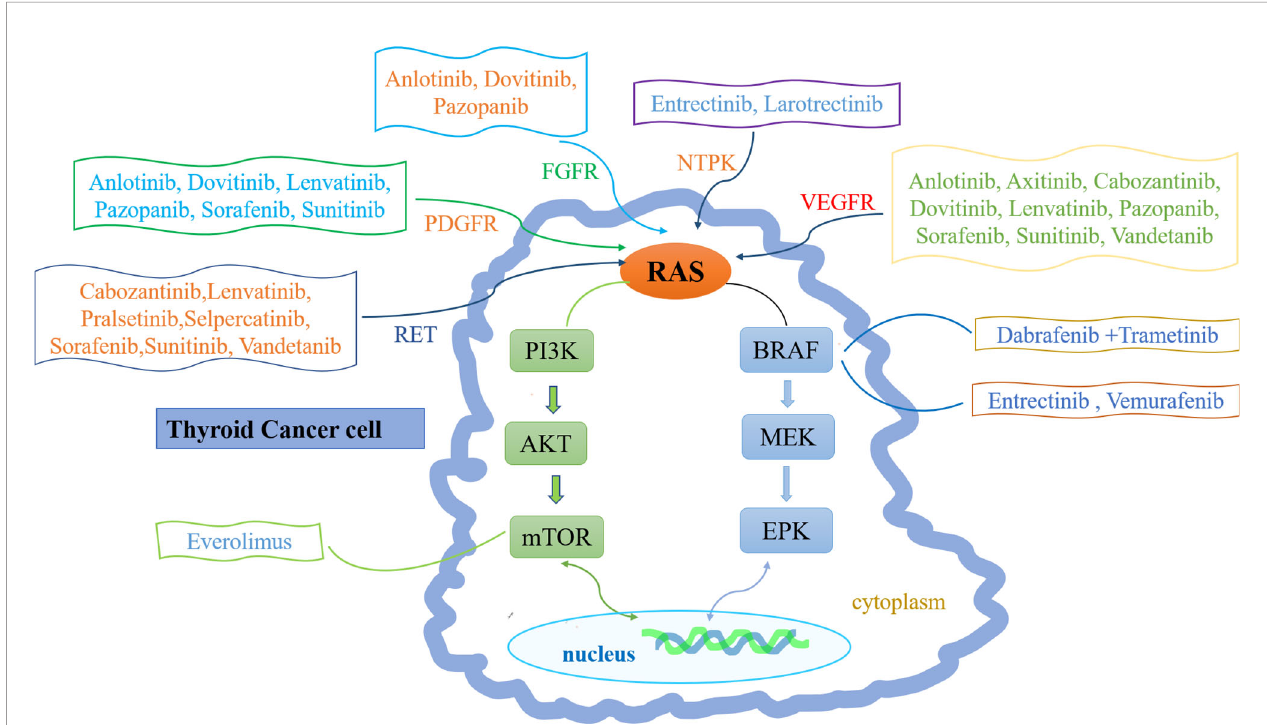
FIGURE 1 | Molecular pathogenesis and therapeutic drug targets of thyroid cancer. The molecular pathogenesis of thyroid cancer mainly involves the imbalance of two classical signaling pathways: mitogen-activated protein kinase (MAPK) (right) and phosphatidylinositol-3 kinase (PI3K)/Akt (left). Ras can transmit receptor tyrosine kinase (RTK) signals to these two pathways. Common mutations in MAPK pathway include RET-PTC and NTPK rearrangement, RAS and BRAF mutations. Common changes in PI3K pathway include RAS mutation, PTEN mutation or deletion, PIK3CA mutation or ampli fi cation and AKT1 mutation. Inhibitor drugs that block these signals are also